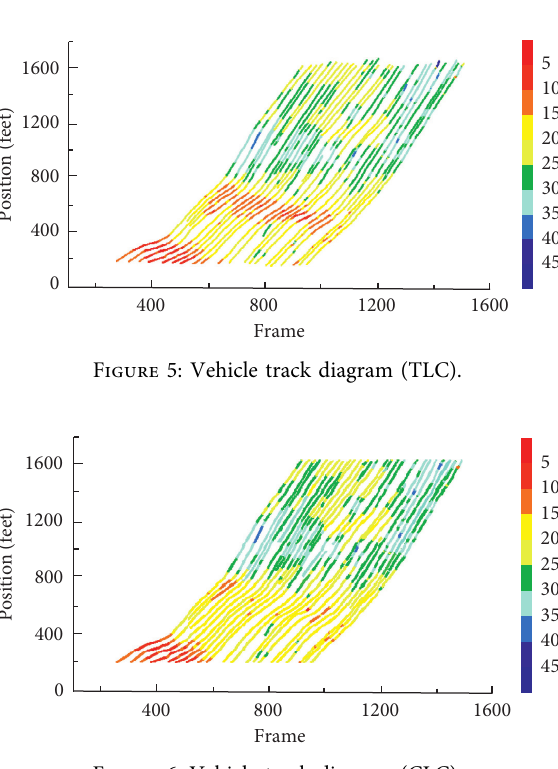
Figure 4: Selected highway scene.